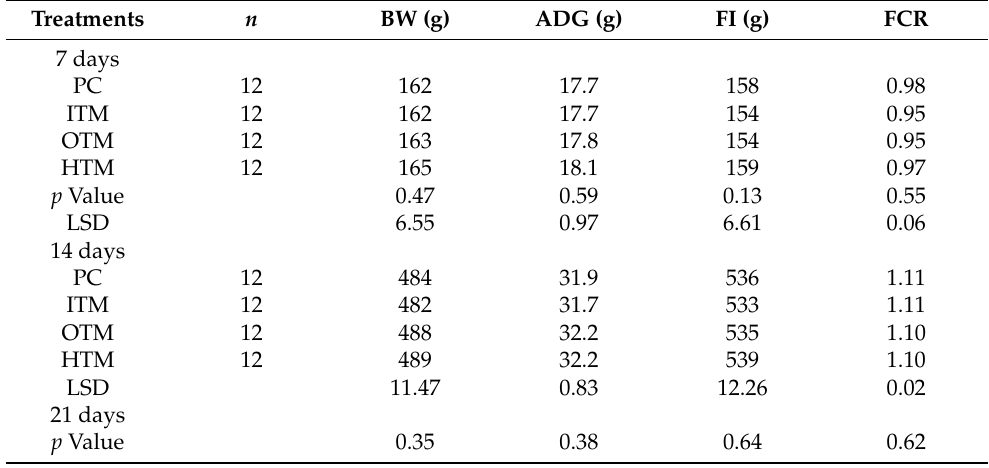
Table 3. Effects of different sources of trace minerals on broiler performance from 0 to 35